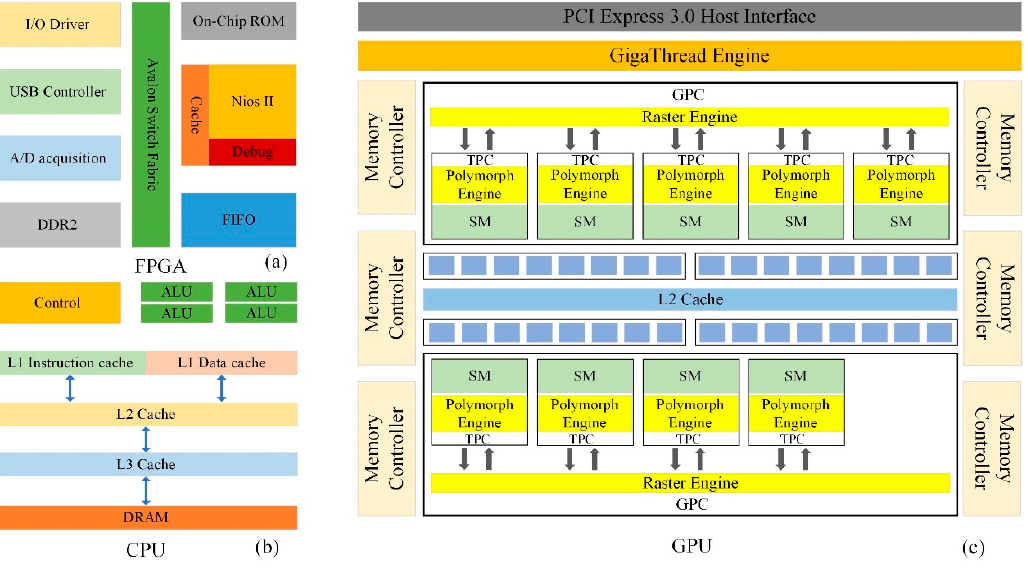
Figure 1. Contrast diagram of field-programmable gate array (FPGA), central processing unit (CPU) and graphics processing unit (GPU) internal structure: ( a ) the internal structure of FPGA ( b ) the internal structure of CPU ( c ) the internal structure of GPU.